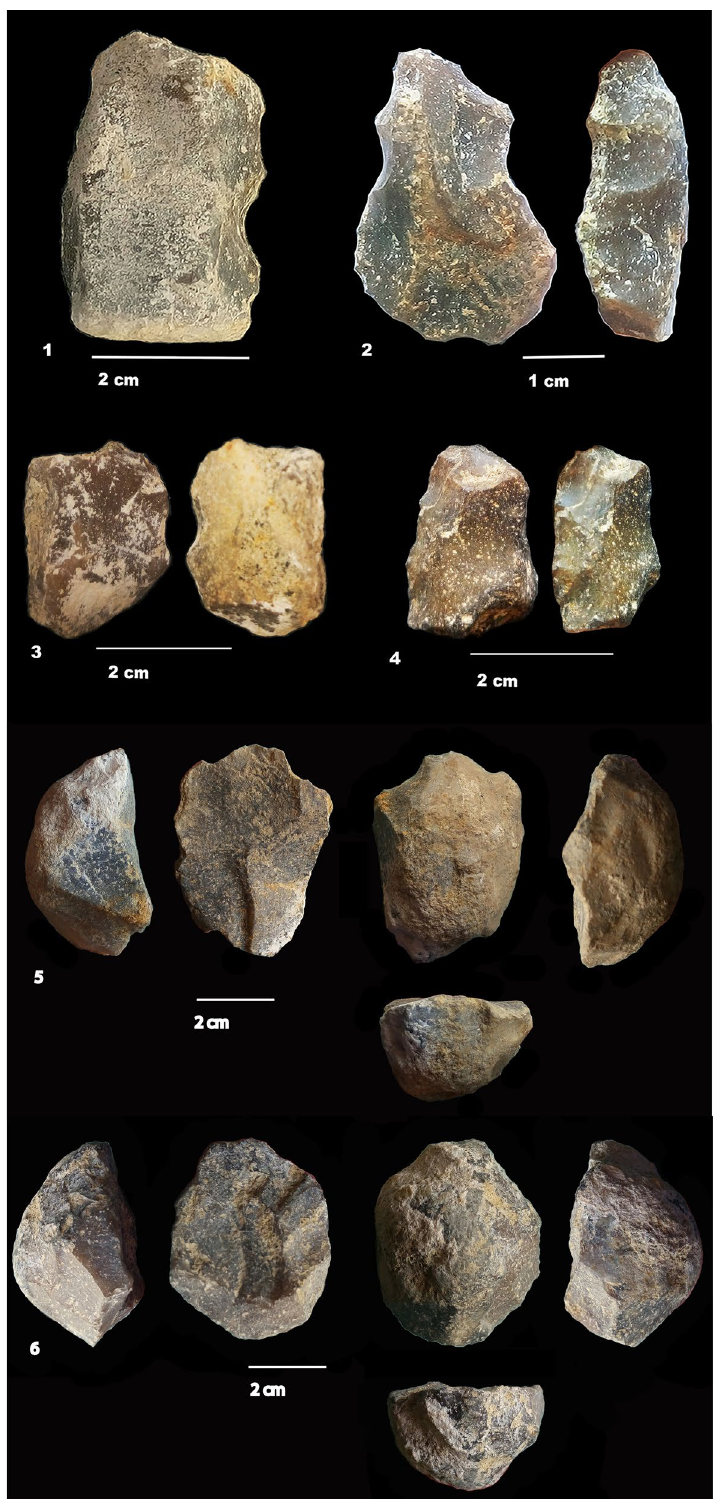
Figure 4. Artefacts on chert nodules. ( 1 – 4 ) small retouched nodules from layers G and I.Hominins selected small quadrangular nodules for a direct, abrupt and denticulate retouch. ( 5 – 6 ) unifacial discoid-type cores (layer I2). Removals are centripetal. The preparation of the striking platform is limited or absent. (Photos M-H. Moncel, C.